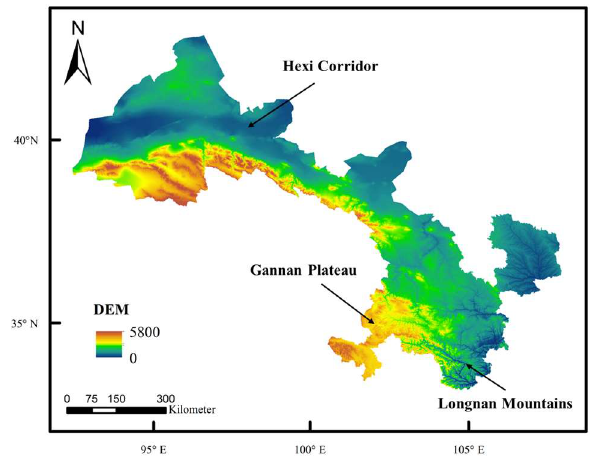
Figure 1 . Location of Gansu